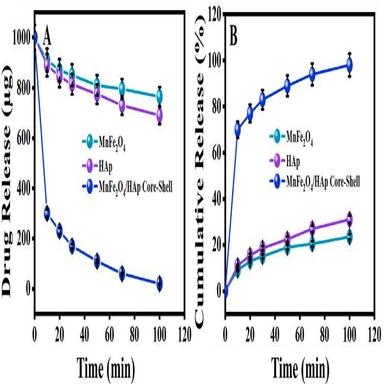
(A) ACP amount of drug release (B) ACP drug release cumulative (%).